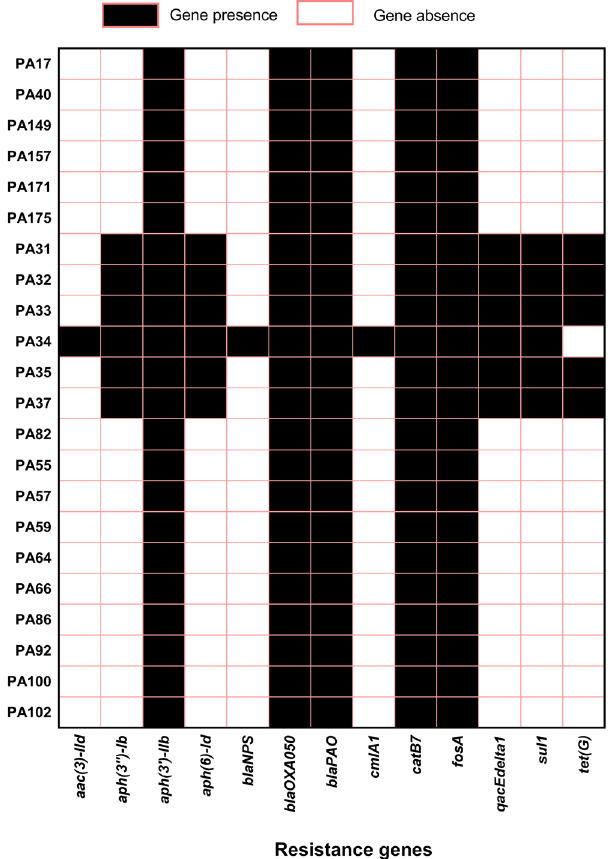
Figure 3. The presence and absence of resistance genes as detected by Resfinder database. Associated resistance: Beta lactams: - bla OXA-50 , bla PAO, , bla NPS-1 Aminoglycosides: - aph ( 3 ′ ) -IIb , aph ( 6 ) -Id , aph ( 3 ″ ) -Ib , aac ( 3 ) -IId Fosfomycin: fosA Sulphonamide: sul1 Chroramphenicol: cmlA1 , catB7 Tetracycline: tet (G). Quaternary ammonium compounds: qacEdelta1